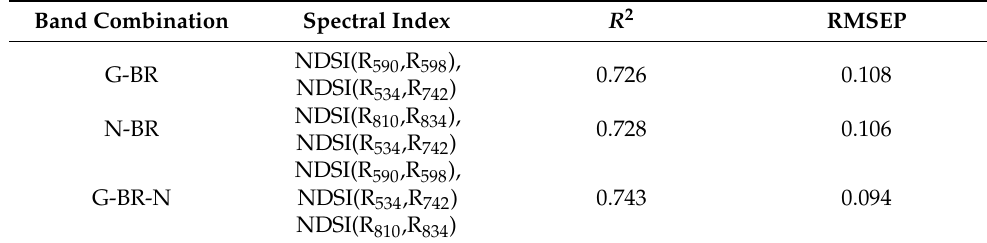
Table 5. Band combinations with the highest validation